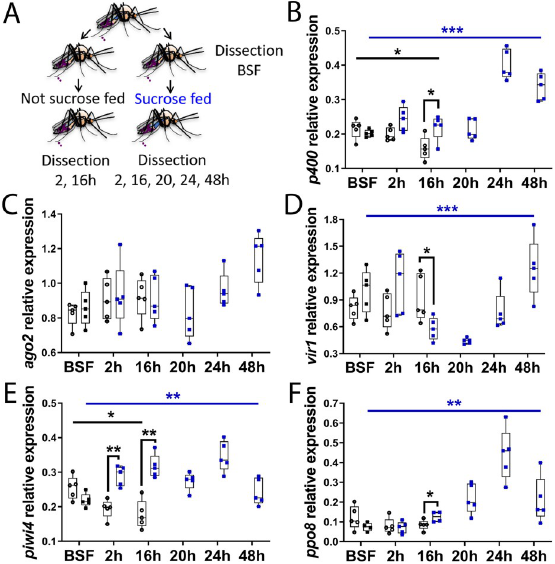
Fig 1. Sucrose feeding increases the expression levels of antiviral genes in the digestive tract of the female Ae . aegypti . (A) Schematic of experimental design. Females that did not have access to sucrose for 48 h were fed or not with 10% sucrose solution. Digestive tracts from both populations were dissected just before sucrose feeding (BSF) and at 2 and 16 h post sucrose feeding time, and at 20, 24 and 48 h for the sucrose fed females. (B to F) RNA transcript levels of (B) p400 , (C) ago2 , (D) vir1 , (E) piwi4 and (F) ppo8 (black empty dots and black squares, non-sucrose fed; blue squares, sucrose fed). Box plots display the minimum, first quartile, median, third quartile, and maximum relative expression levels. Data were analysed by Mann-Whitney test (non-sucrose vs sucrose fed at each time point, BSF, 2 and 16 h) and by Kruskal-Wallis test (all times, for non-sucrose fed and sucrose fed, black and blue bars respectively showing p value summary). N = 5 pools of 5 digestive tracts per condition. Only p values < 0.05 are shown. � , p value < 0.05; �� , p value < 0.01; ��� , p value <